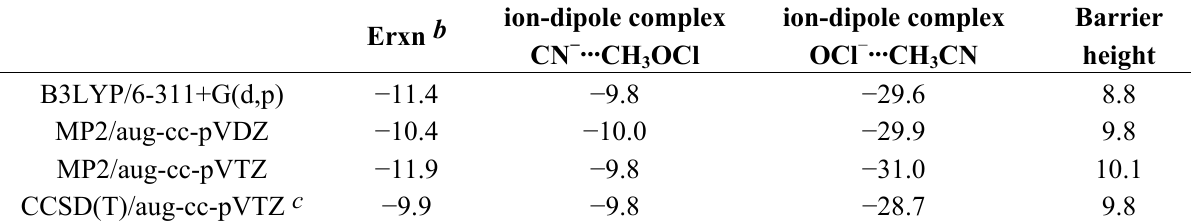
Table 7. Calculated reaction energetic a (in kcal/mol) of the gas-phase CN − + CH OCl − + CH CN 3